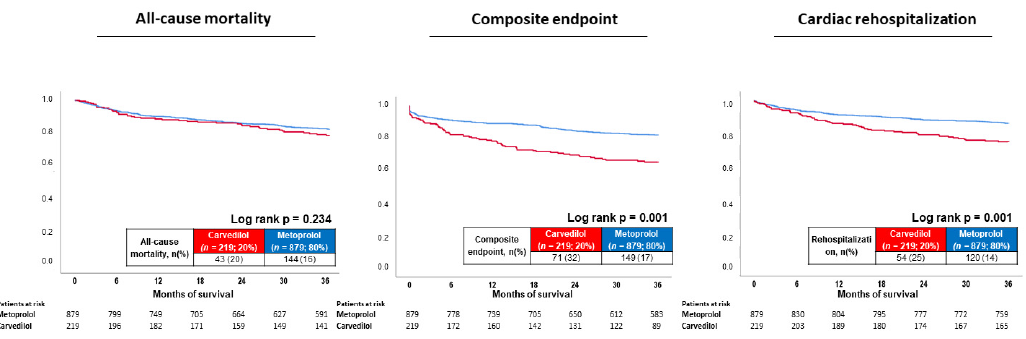
Figure 2. Prognostic impact of metoprolol versus carvedilol treatment on all-cause mortality ( left ), risk of the composite endpoint (i.e., recurrence of ventricular tachyarrhythmias, sudden cardiac death) ( middle ), and cardiac rehospitalization ( right ) within the entire study Table 2. Primary and secondary endpoints, follow-up data.